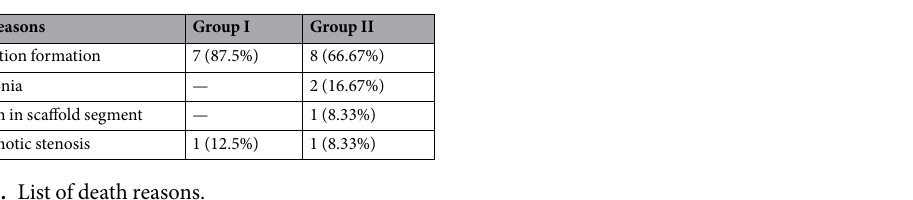
Table 1. List of death